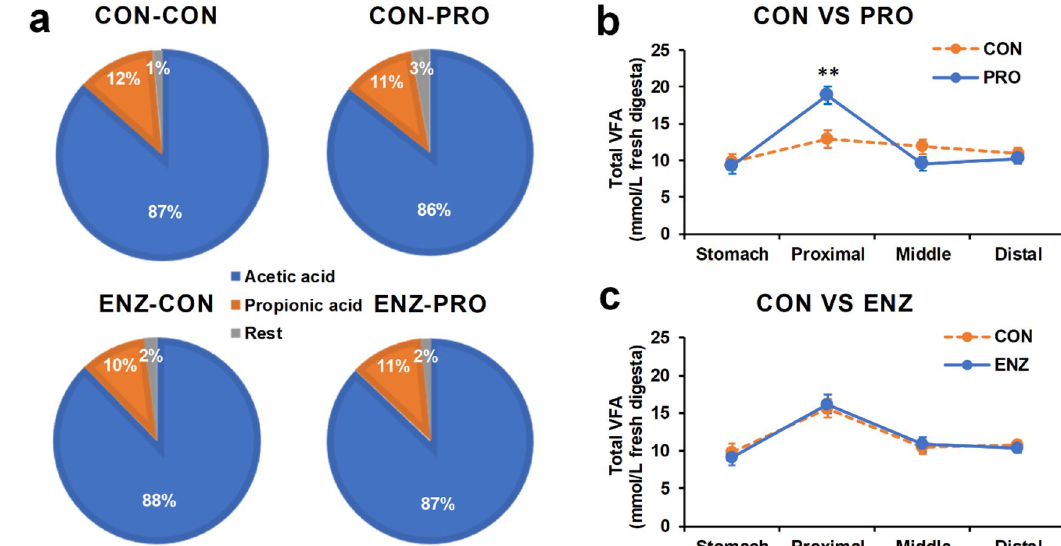
Figure 1. Volatile fatty acid (VFA) composition in fresh chyme along the gastrointestinal tract of Nile tilapia. ( a ) The proportion of the two most abundant VFAs per dietary treatment averaged over the four segments of the gastrointestinal tract. ( b ) The main effect of probiotics supplementation on the total VFA content in fresh chyme along the gastrointestinal tract. ( c ) The main effect of enzyme supplementation on the total VFA content in fresh chyme along the gastrointestinal tract. Error bars indicate standard error of means; ** P < 0.01. CON-CON, no enzymes or probiotics added; CON-PRO, probiotics added; ENZ-CON, enzymes added; ENZ-PRO, enzymes and probiotics